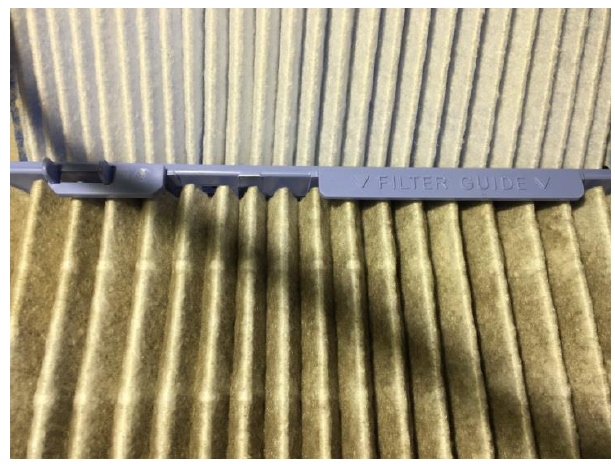
Fig. 1. The filter surface after a few days of operation as domestic air purifier, in the background a new filter for comparison